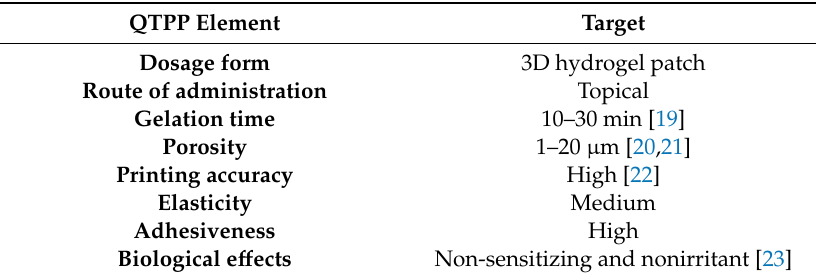
Table 1. Quality target product profile (QTPP) of the 3D hydrogel